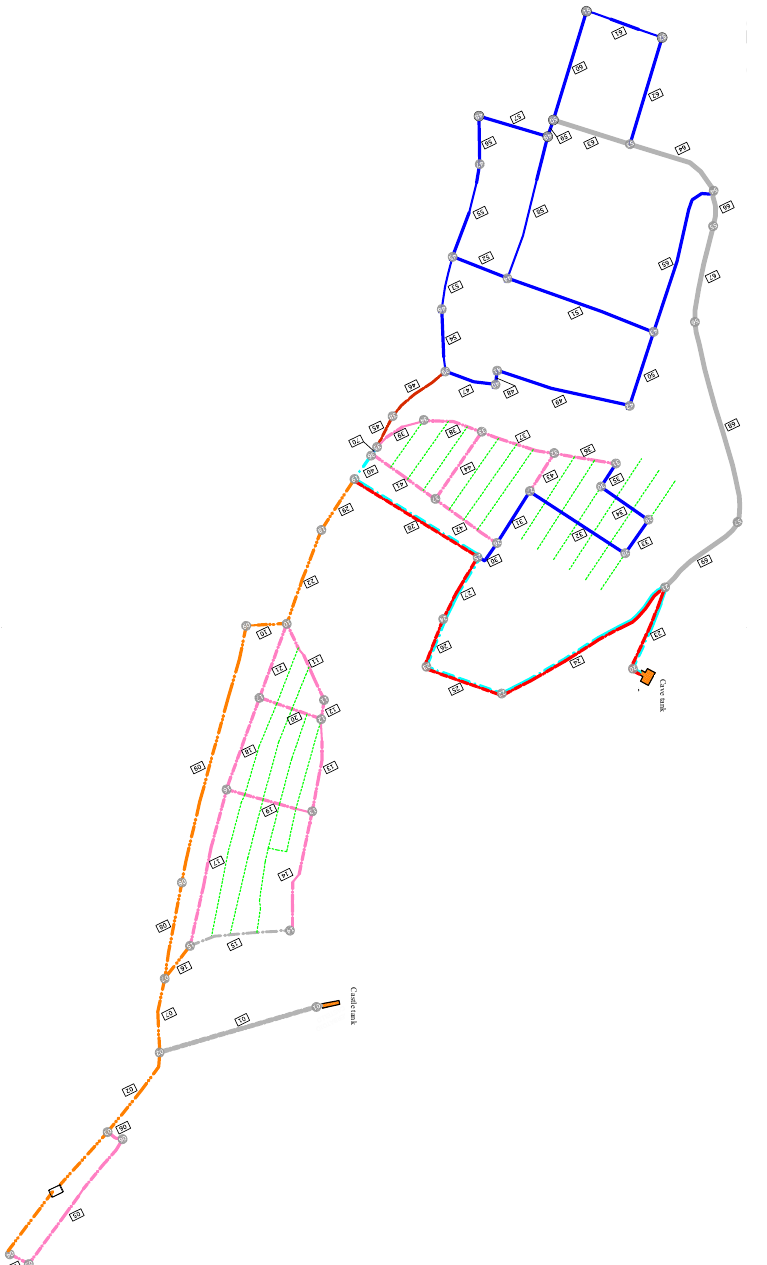
Figure 2. Case study network in Misilmeri (PA). Boxe: pipe number; circle: node number. Colors are representative of pipe diameters. Red line: DN 80 mm; blue line: DN 100 mm; dot dashed gray line: DN 110 mm; dot ‐ dot dashed orange line: DN 150 mm; dashed sky ‐ blue line: DN 200 mm; bold gray line: DN 300 mm. Table 1. PATs characteristic in turbine mode.